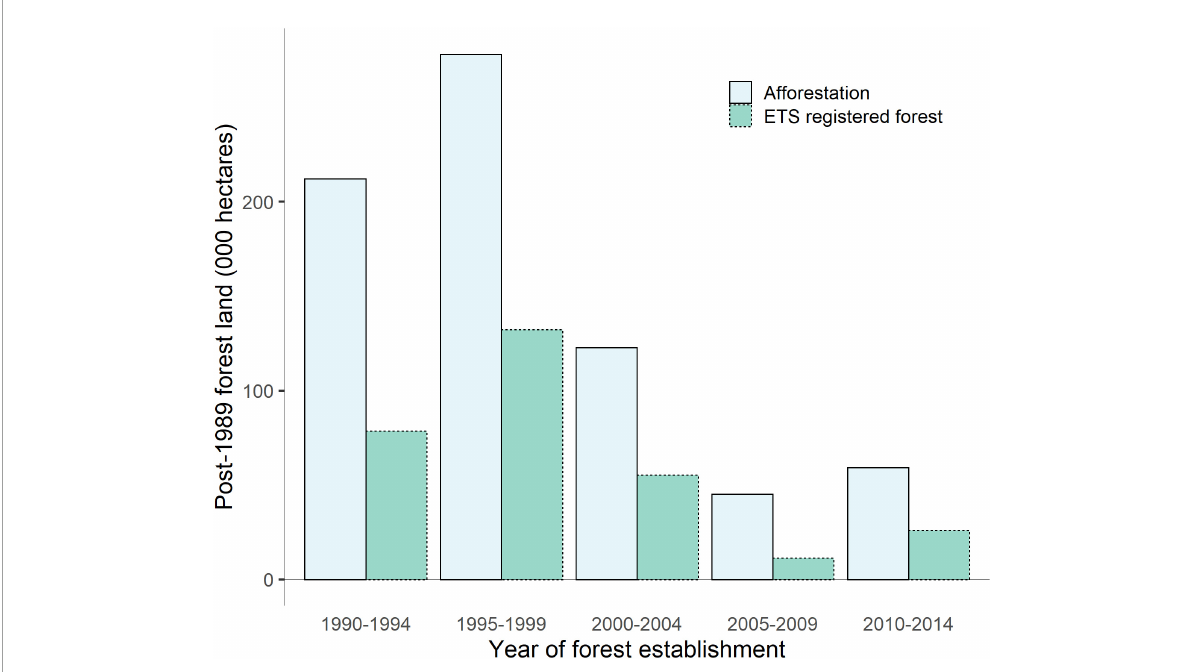
FIGURE2 Estimated annual area of afforested and voluntarily registered post-1989 forest land in the NZ ETS by year of forest establishment. Data from MPI (2016b) and MfE (2022a).